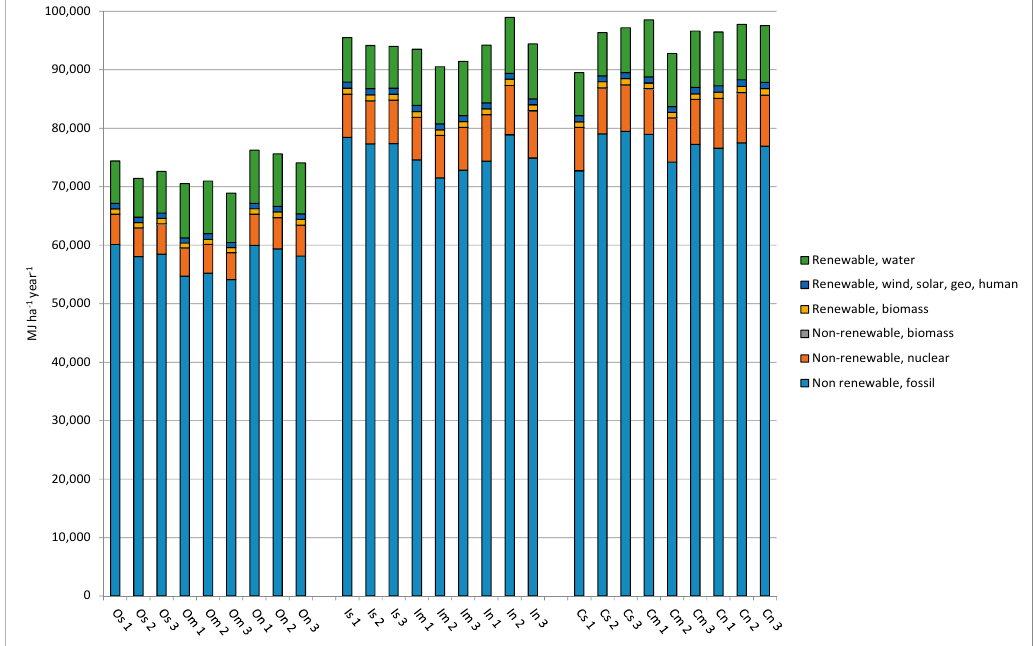
Figure 5. Energy results. Table 3. Energy results in the organic farming system .